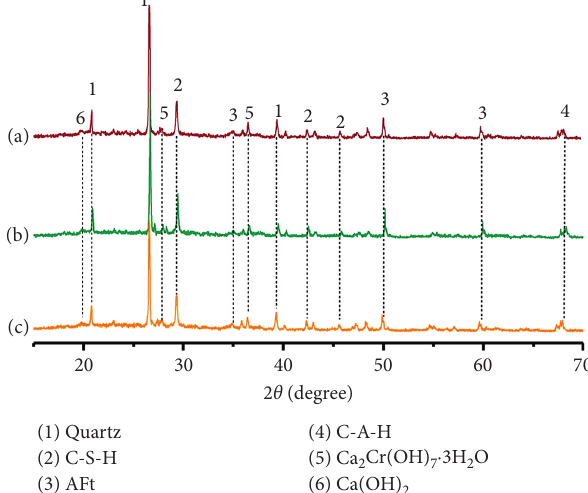
Figure 11: XRD results of Cr-contaminated soil stabilized with C6S24 under different numbers of wetting-drying cycles: (a) 0, (b) 3, and (c) 10.